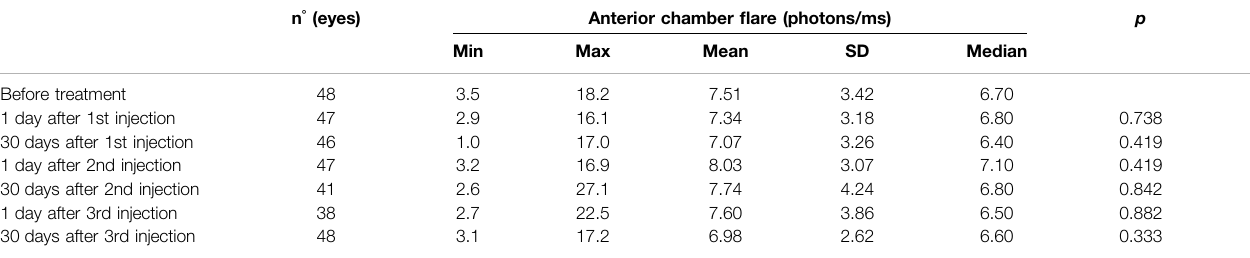
TABLE 1 | Anterior chamber fl are before and 1 day and 1 month after each intravitreal bevacizumab